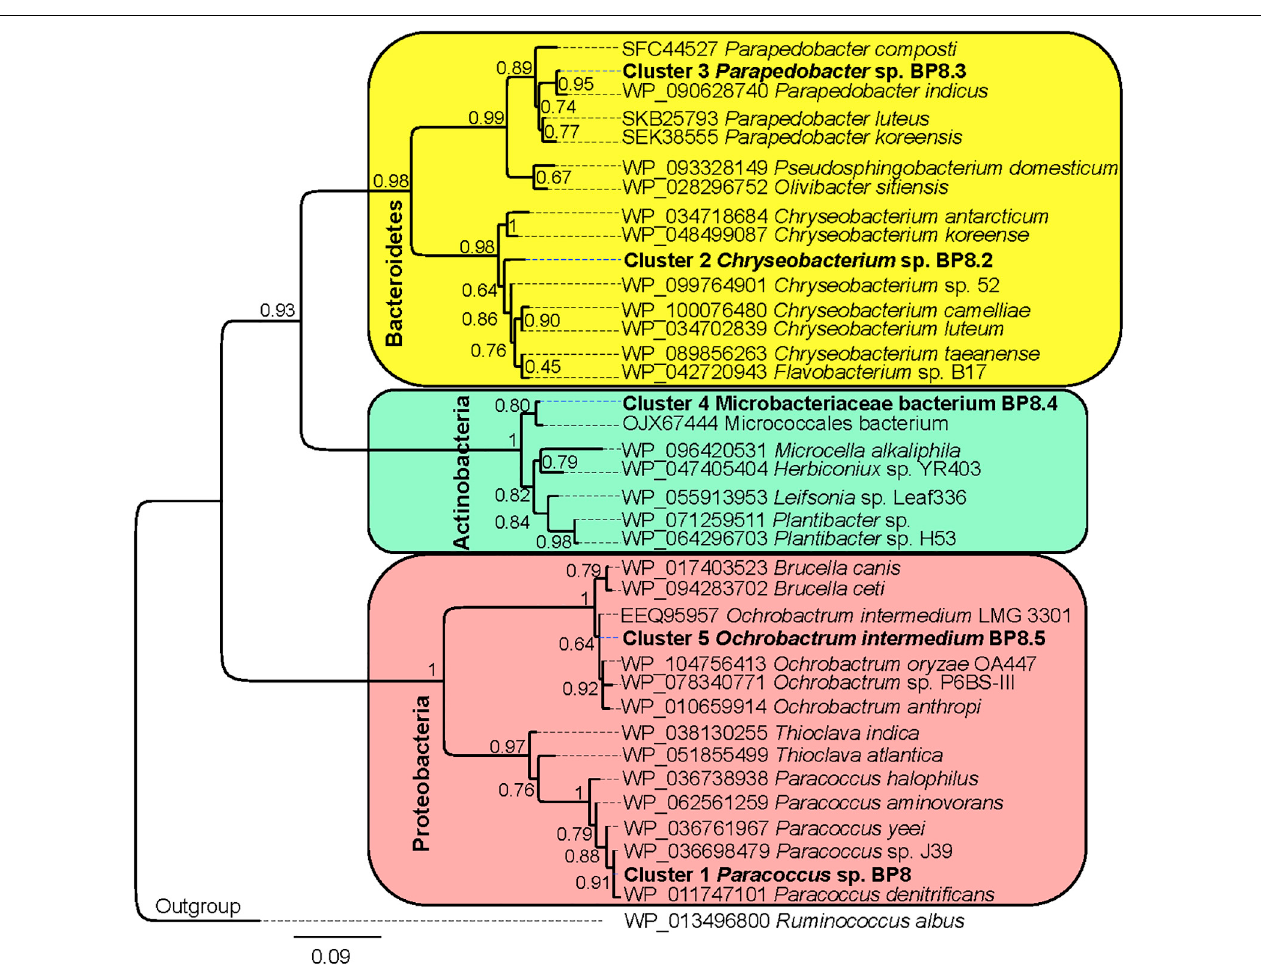
FIGURE 6 | Maximum likelihood phylogeny for taxonomic delimitation of the deconvoluted genomes from the BP8 metagenome. The analysis was performed with three phylogenetic markers: ribosomal protein L3, ribosomal protein S5 and DNA gyrase A subunit, which generated similar results. The analysis for ribosomal protein L3 is presented. Branch support values are indicated in the corresponding nodes. Bar indicates the number of expected substitutions per site under the WAG + G model. A sequence of Ruminococcus albus (Firmicutes) was used as outgroup. Key genome clusters are highlighted in bold and different Phyla are indicated at the left. Sequences for L3 ribosomal proteins of the deconvoluted genomes are accessible in the NCBI GenBank under accession numbers RQP07704.1, RQP15098.1, RQP16503.1, RQP08603.1, and RQP16393.1 for clusters 1–5, respectively.